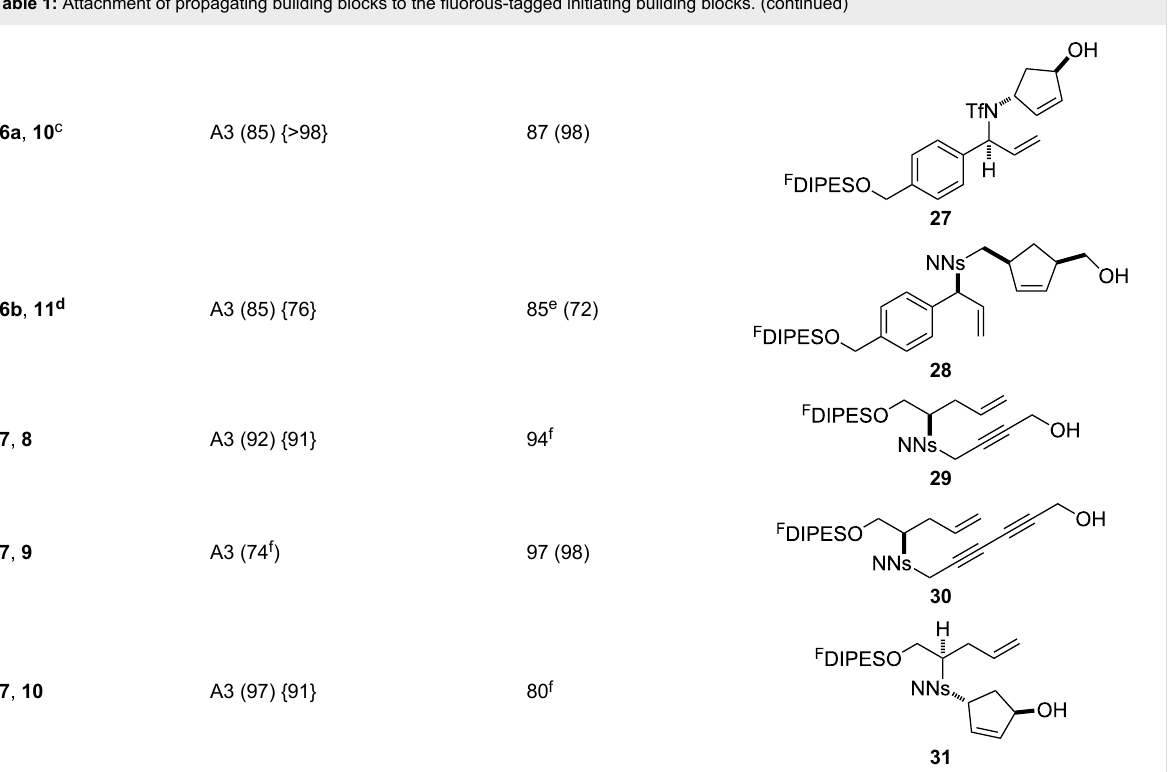
Table 1: Attachment of propagating building blocks to the fluorous-tagged initiating building blocks. (continued)